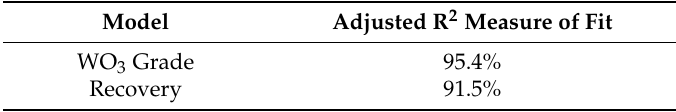
Table 5. Adjusted R 2 values for fitted models of grade and